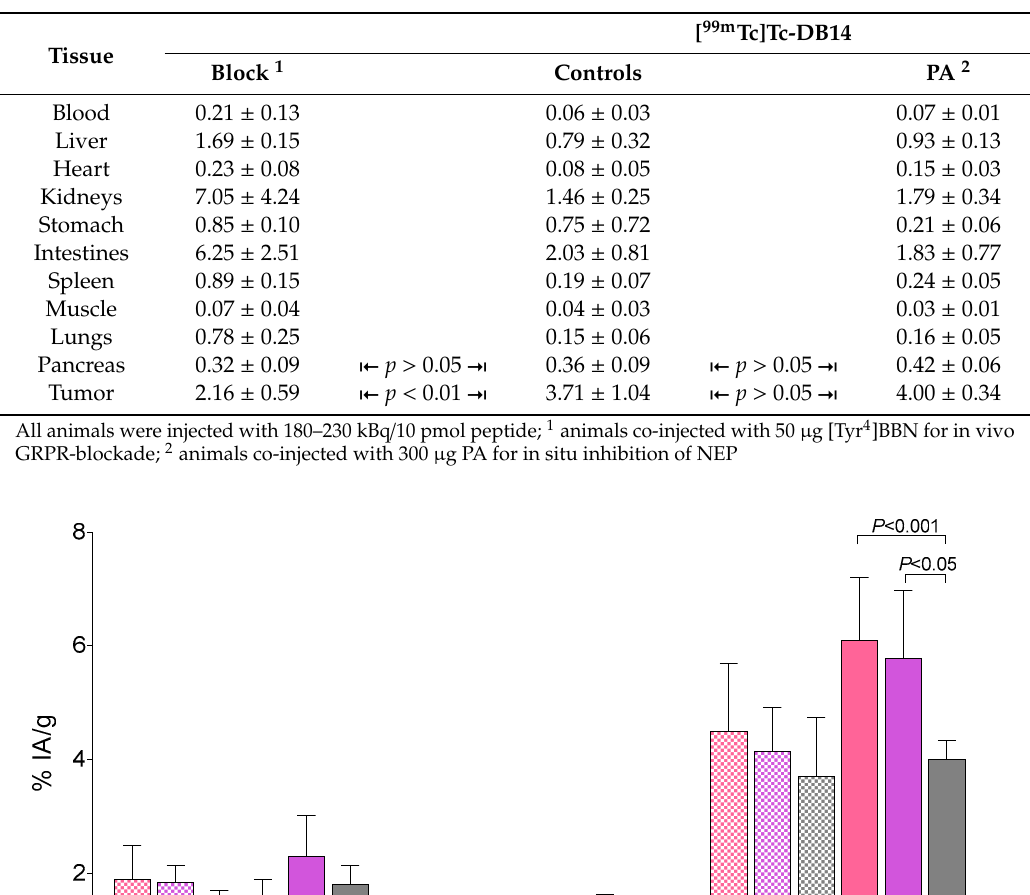
Table 1. Biodistribution data for [ 99m Tc]Tc-DB7, expressed as %injected activity per gram tissue (%IA/g) mean ± SD, n = 4, in PC-3 xenograft-bearing severe combined immunodeficiency disease (SCID) mice at 4 h pi.